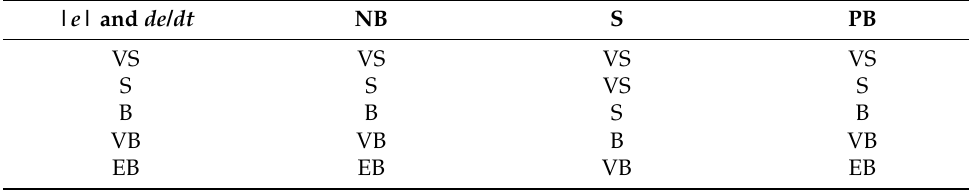
Figure 5. MRAC Structure: ( a ) Lyapunov; ( b ) MIT rule. Table 1. Fuzzy MRAC rule base for adaptation